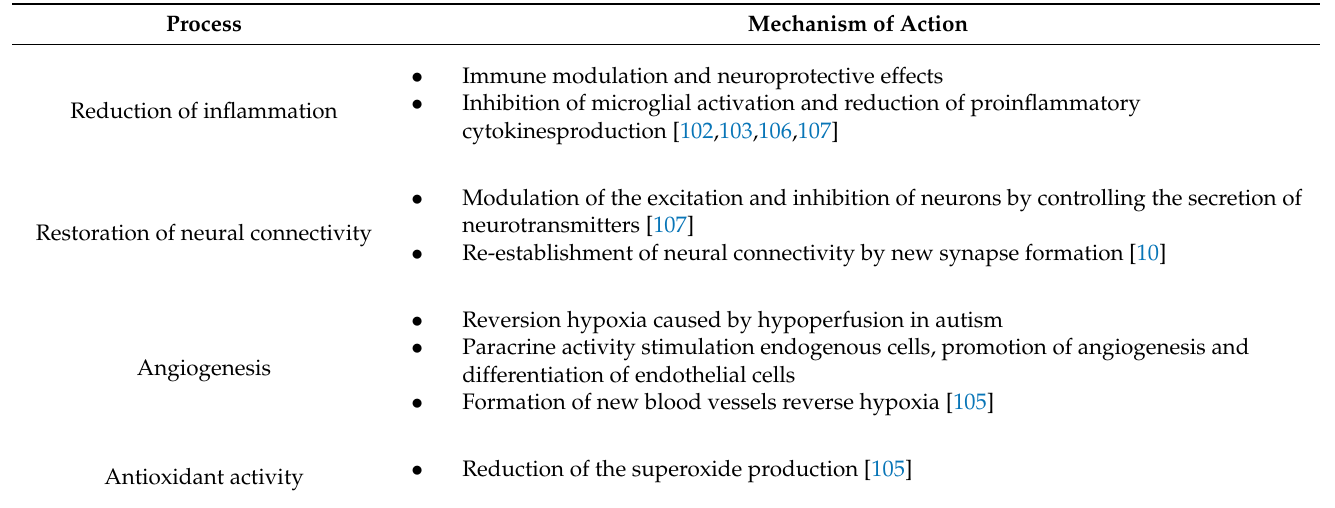
Table 2. Stem cell mechanisms of action in ASD